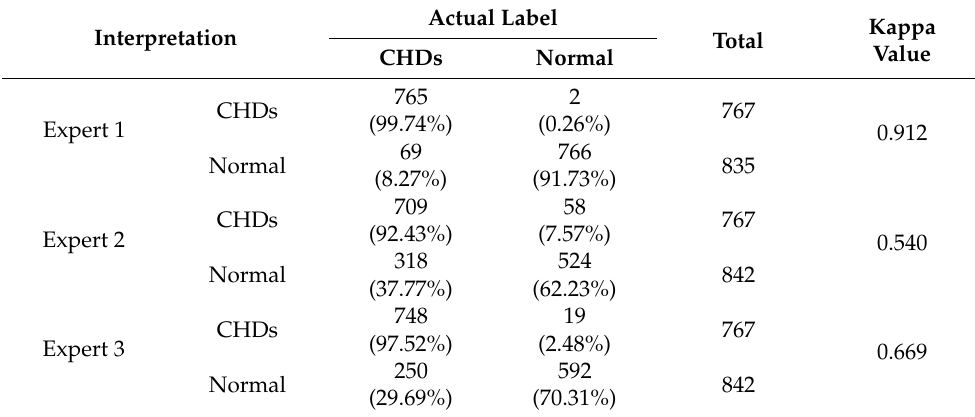
Table 7. Interpretation by expert fetal